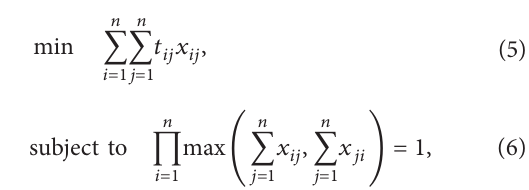
1 → 2 → 3 → 4 → 5 on a workpiece has the same distance travelled and time taken as drilling five holes in the opposite sequence 5 → 4 → 3 → 2 → 1. After the best route for the cutting tool is found, say 3 → 4 → 5 → 1 → 2, the cutting tool has to just drill all five holes and stop at the last hole and reverse the sequence of drilling for the next workpiece, 2 → 1 → 5 → 4 → 3. With this in mind, the objective function of PCB drilling process can be expressed